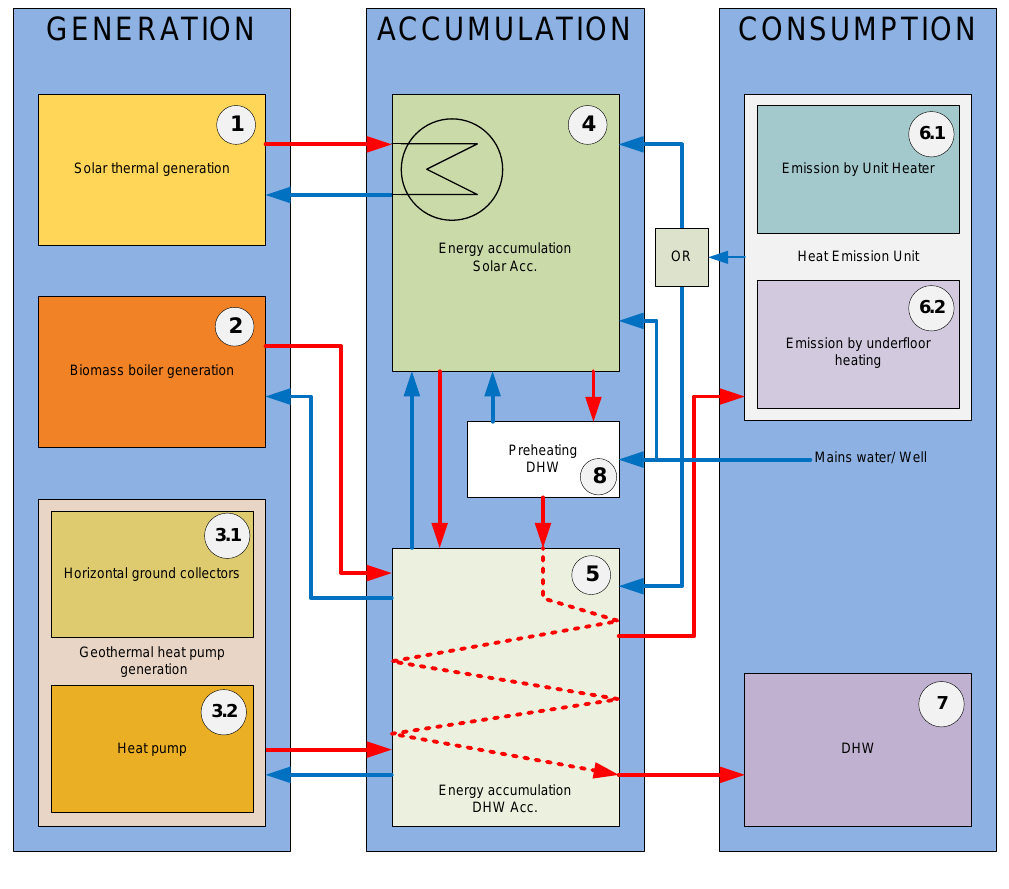
Figure 2. Thermal energy installation schematic.